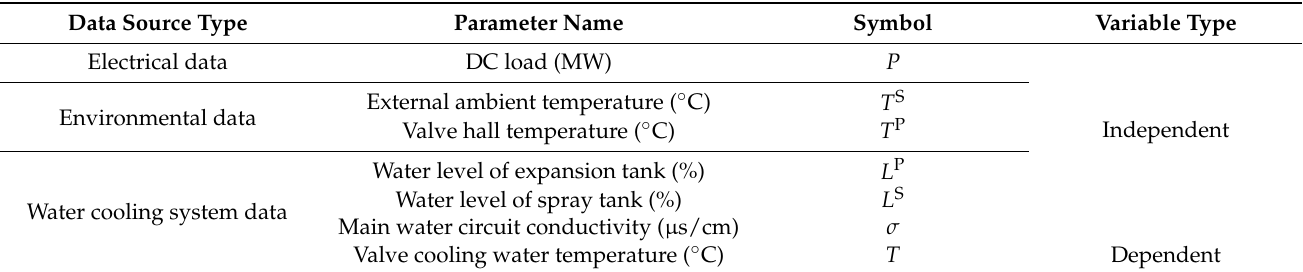
Table 1. Operating parameters of the cooling system of an HVDC converter